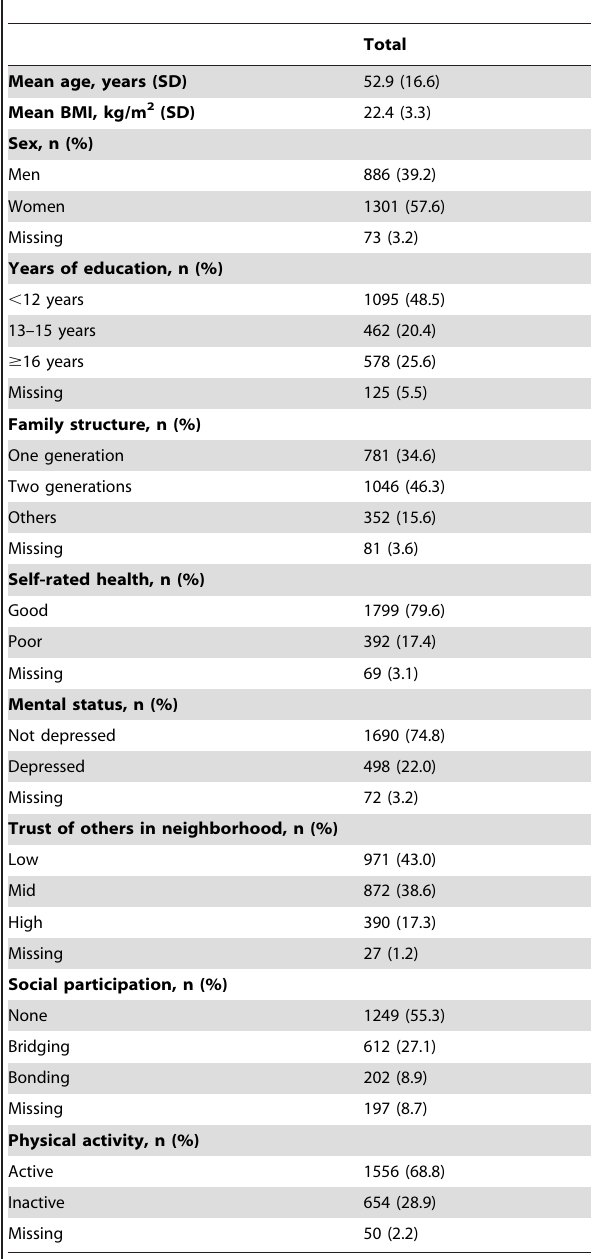
Table 2. Number of subjects by cognitive and structural social capital status in Okayama, Japan